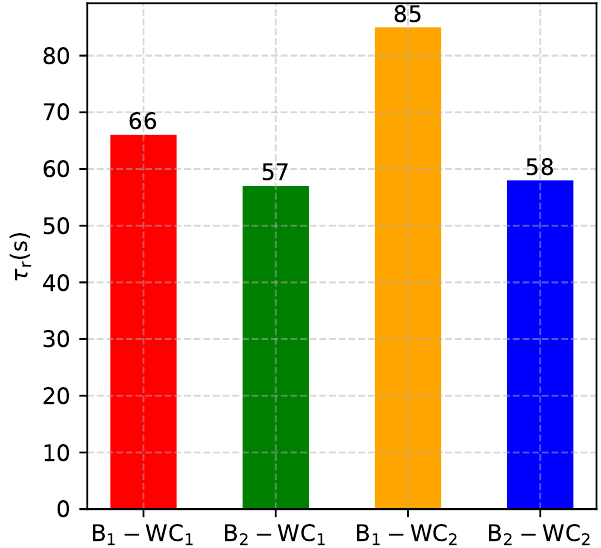
Figure 14. The value of τ r of bionic designs under 2 working